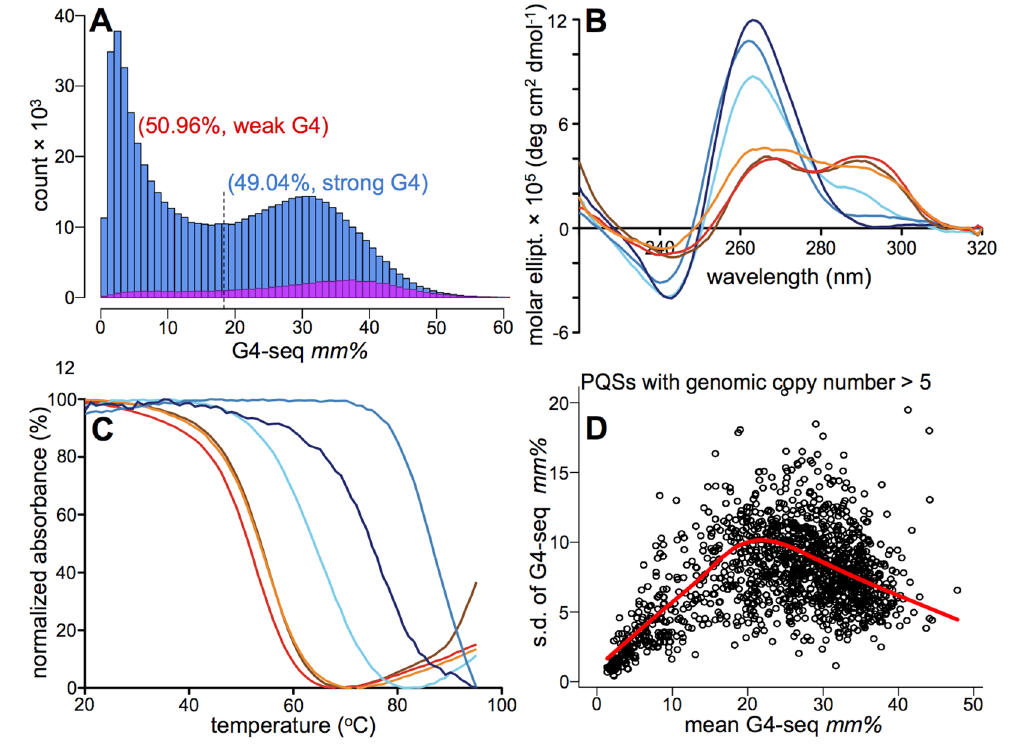
Figure 3. Canonical putative quadruplex sequences do not necessarily form stable genomic G4s. ( A ) The distribution of mm% values for PQSs, highlighting the presence of two clusters. ( B ) Example CD spectra for sequences from the weak- (shades of red) and strong-G4 (shades of blue) clusters (as judged from G4-seq mm% values). The CD signature for G4 comprises ~260 nm maximum and ~240 nm minimum for parallel topology, or ~290 nm maximum and ~260 nm minimum for antiparallel topology 42,43 . ( C ) The example UV-melting (for 295 nm) spectra from the same sequences in ( B ). The chosen sequences with their respective mm% and T m (UV melting temperature) values are highlighted in Table S1, using the same colour code. The increased absorbance for some samples, after the full melting of G4 structures, is most probably due to a partial evaporation from the solution during the continuous measurement at high temperatures. ( D ) The G4-seq mm% variance vs. mean value dependence for PQSs with multiple genomic copy numbers, where only the flanking sequences are different, to directly demonstrate the role of flanks on G4 formation propensity. See also Figures S10–S14, Tables S1 and